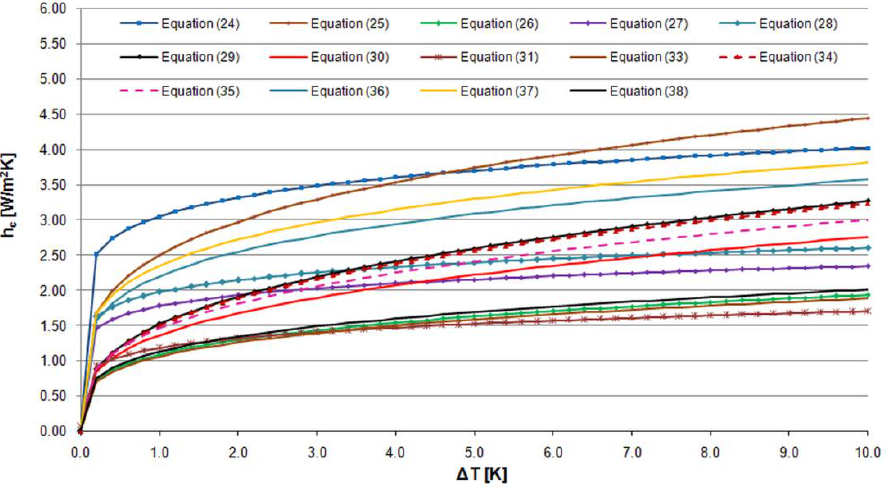
Figure 11. CHTC for different models.